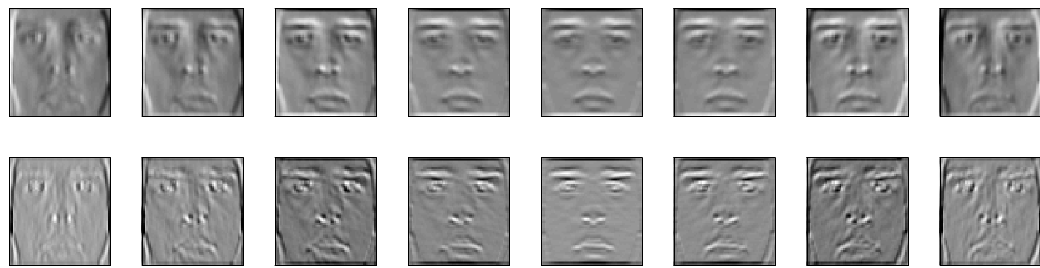
Figure 5. Examples of multiple Gaussian derivative filter images obtained by convolving normalized facial images with the Gaussian derivative filters shown in Figure 4.